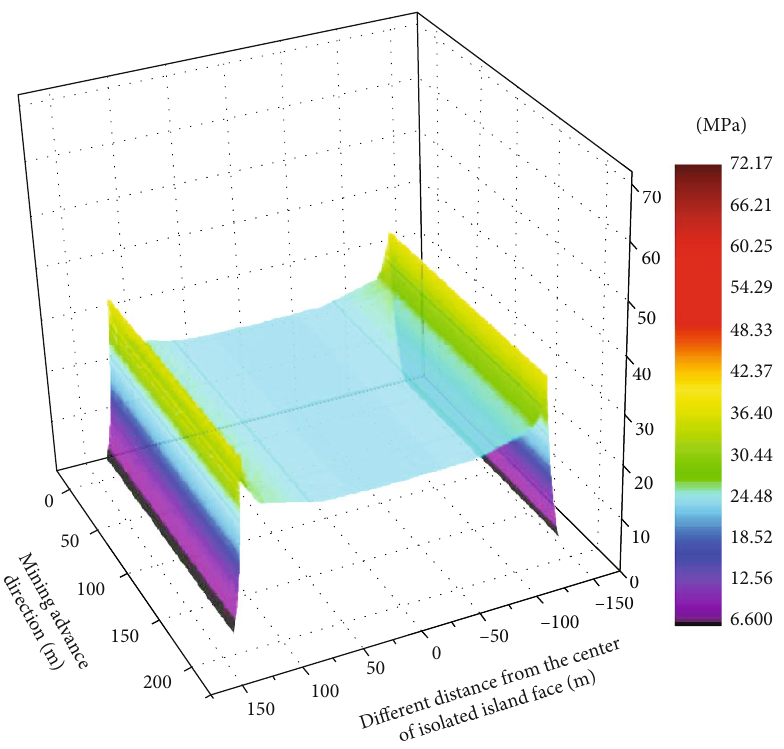
Figure 9: Characteristics of the distribution of lateral mining stress in the isolated coal